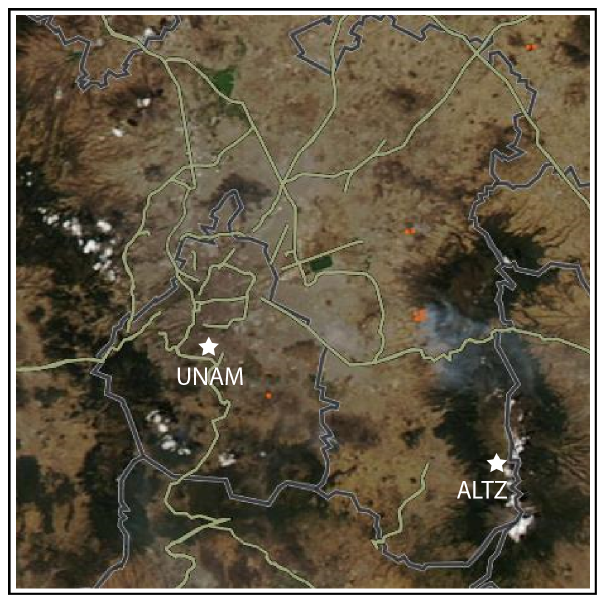
Figure 5. Snapshot of Mexico City’s fire events on 27 Febru- ary 2013, from the Aqua MODIS instrument with true colour- corrected reflectance and resolution of 25m, obtained from NASA Worldview Snapshots (https://earthdata.nasa.gov, last access: 21 October 2022). The red dots show the fire events. The stars indi- cate the location of the UNAM and Altzomoni stations.